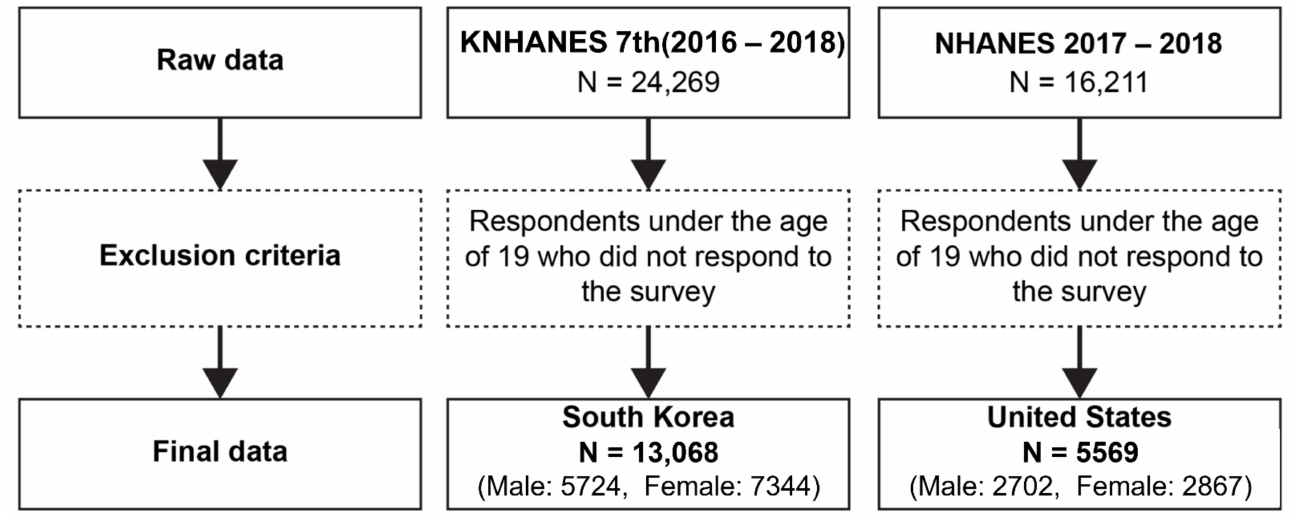
Figure 1. Process of selecting